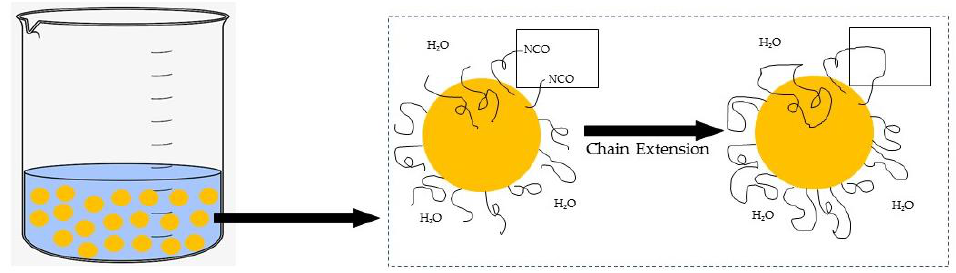
Figure 5. The reaction of chain extension.